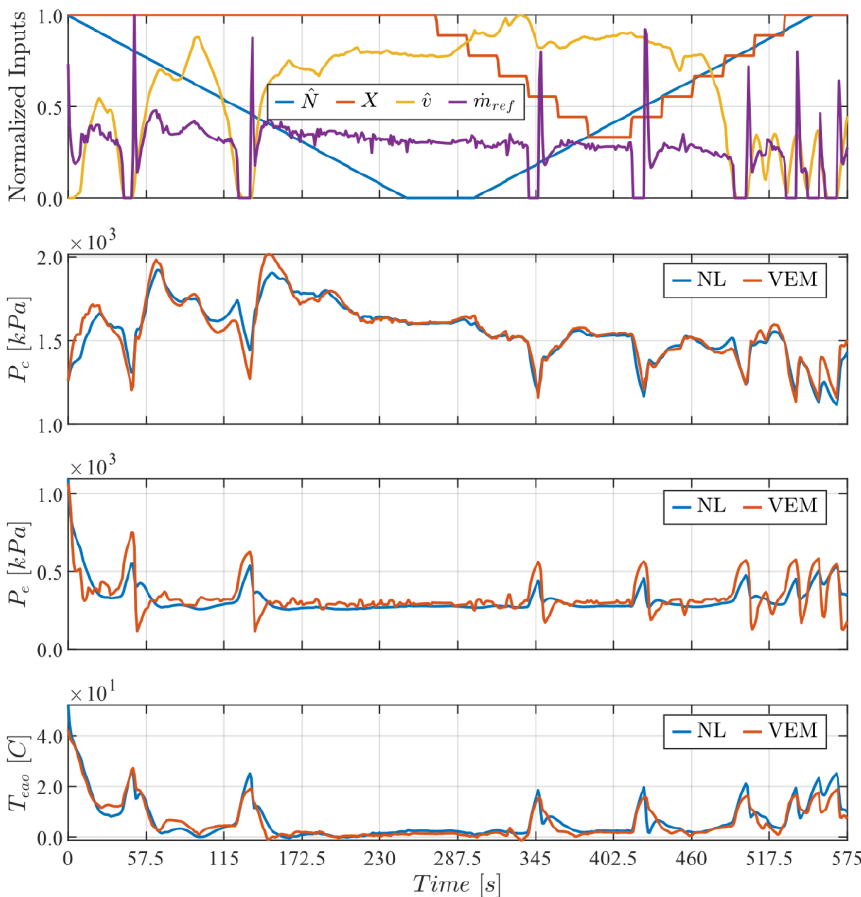
Figure 4. VEM and NL pressure and temperature comparison for custom drive cycle.